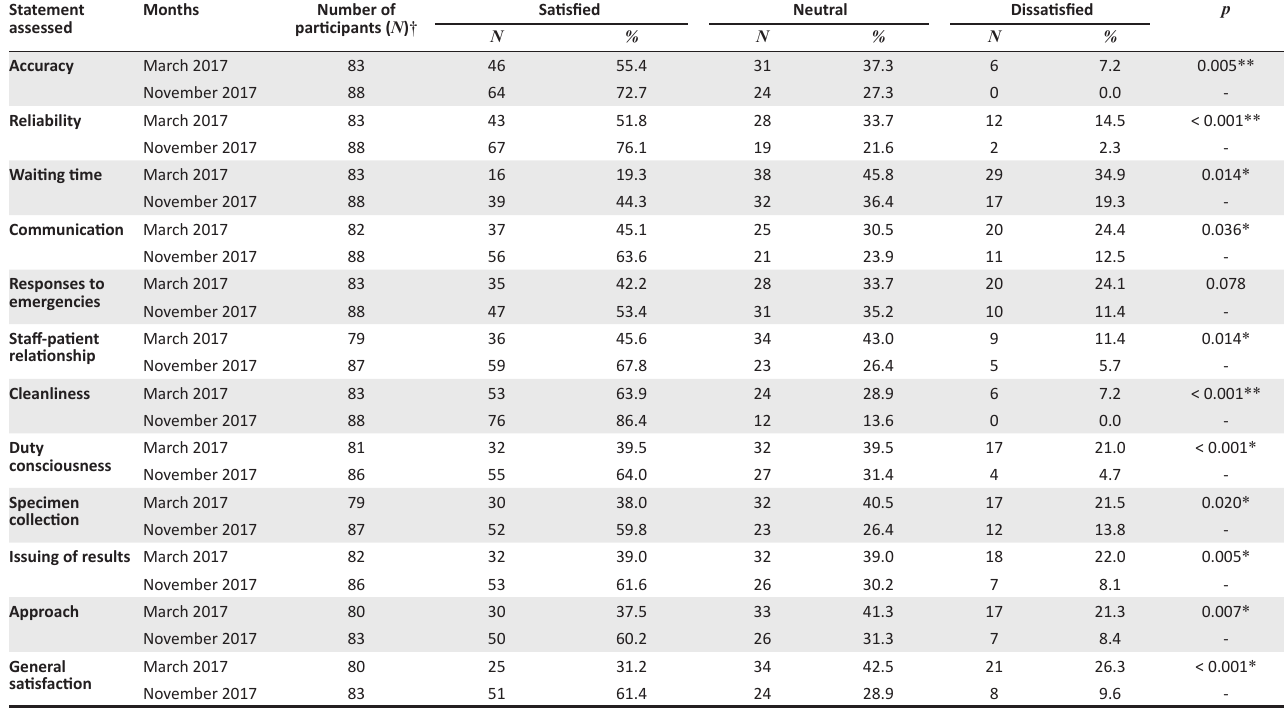
TABLE 2: Distribution of responses to the assessed statements exploring clinicians’ views on laboratory services from the same population in March 2017 and November 2017 at Bamenda Regional Hospital Laboratory, Cameroon. Statement